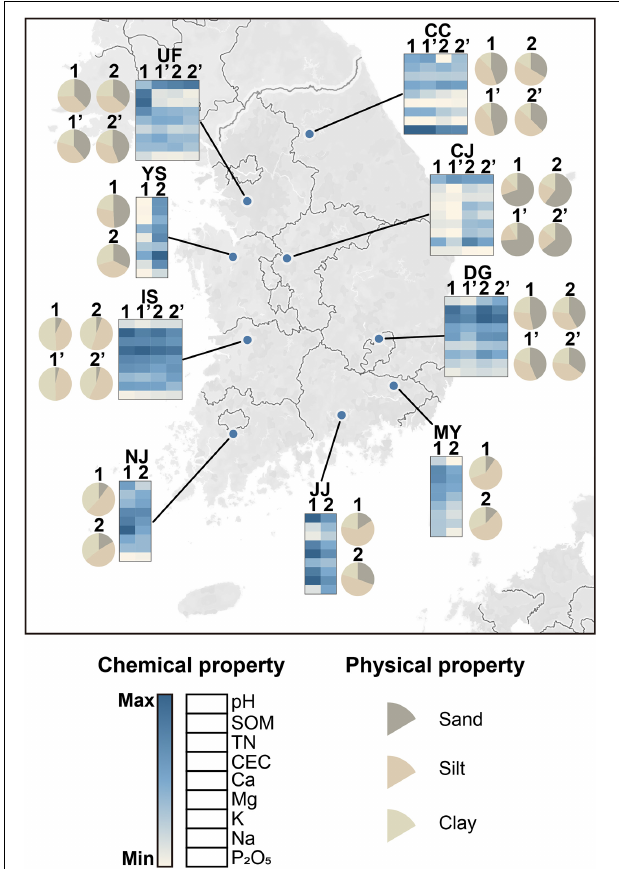
FIGURE 1 | Geographic distribution of soil sampling sites and physicochemical properties of the fields. The latitudes and longitudes of the sites were visualized with Tableau Desktop (2019.4). Heat maps were constructed with Morpheus software (https://software.broadinstitute.org/morpheus/). Each square in the heat map indicates chemical properties quantified in this study. Colors indicate the relative values of the chemical properties across all fields. Pie charts show the proportions of sand, silt, and clay particles. Numbers indicate the paddy fields examined at each site. The fields investigated in 2018 are indicated by apostrophes next to the field numbers. Values of the soil physical and chemical properties are listed in Supplementary Table 1 . CC, Chuncheon; CJ, Cheongju; DG, Daegu; IS, Iksan; JJ, Jinju; MY, Miryang; NJ, Naju; UF, University Farm (Suwon); YS, Yesan; SOM, soil organic matter; TN, total nitrogen; CEC, cation-exchange capacity (number of exchangeable